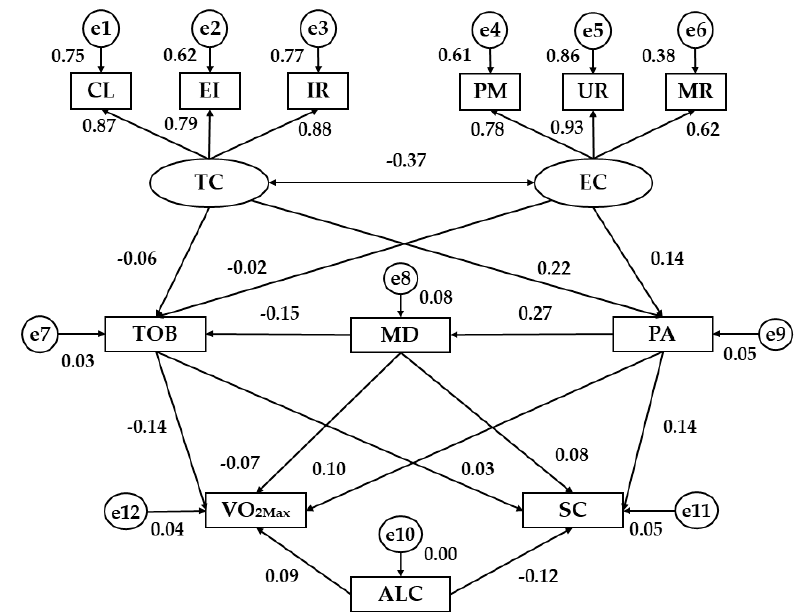
Figure 2. Structural equation model for men. Note: TC, Task Climate; EC, Ego Climate; CL, Cooperative Learning; EI, Effort/Improvement; IR, Important Role; PM, Punishment for Mistakes; UR, Unequal Recognition; MR, Member Rivalry; TOB, Tobacco; MD, Mediterranean Diet; PA, Physical Activity; ALC, Alcohol; VO 2MAX , Maximum oxygen consumption (mL/min/kg); SC; Self- concept.